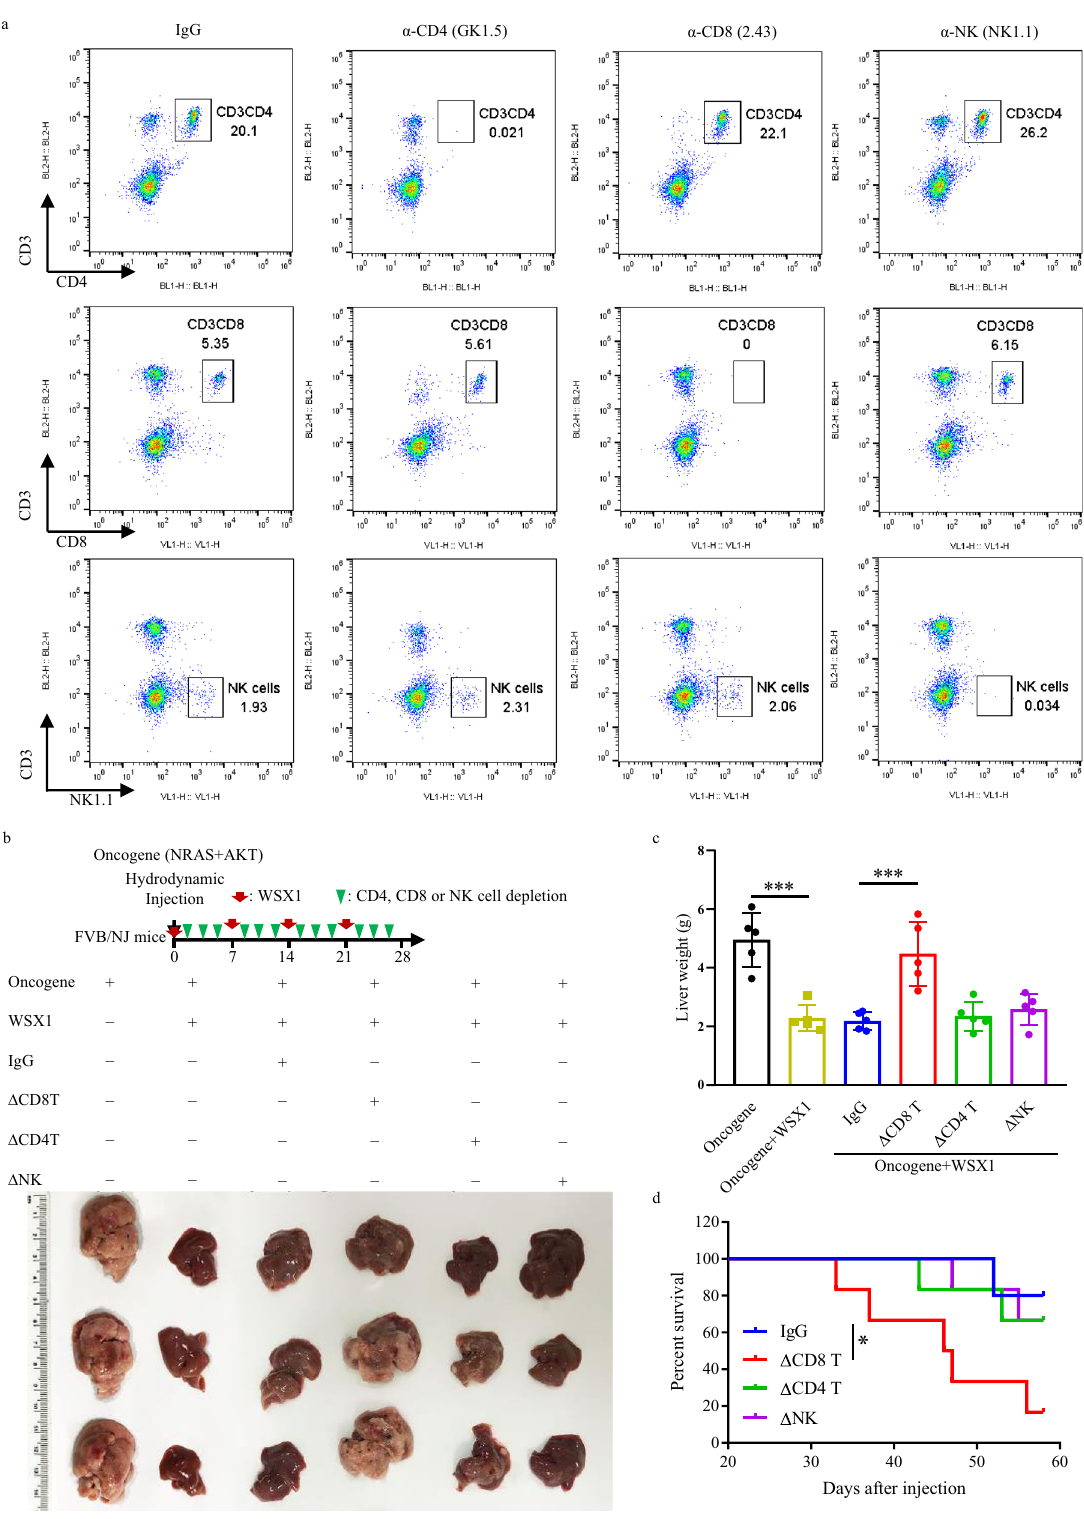
no visible explicit boundaries at which to distinguish tumor